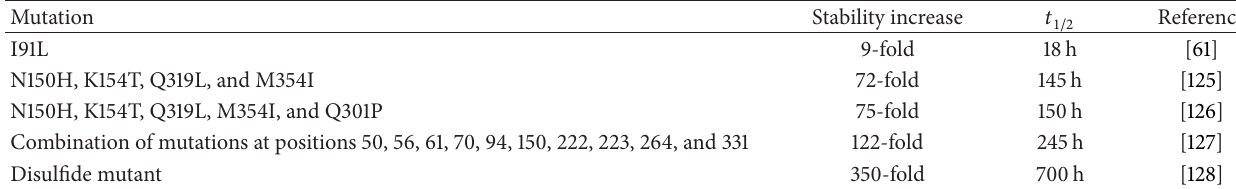
Table 1: Random mutagenesis approach to the stability of